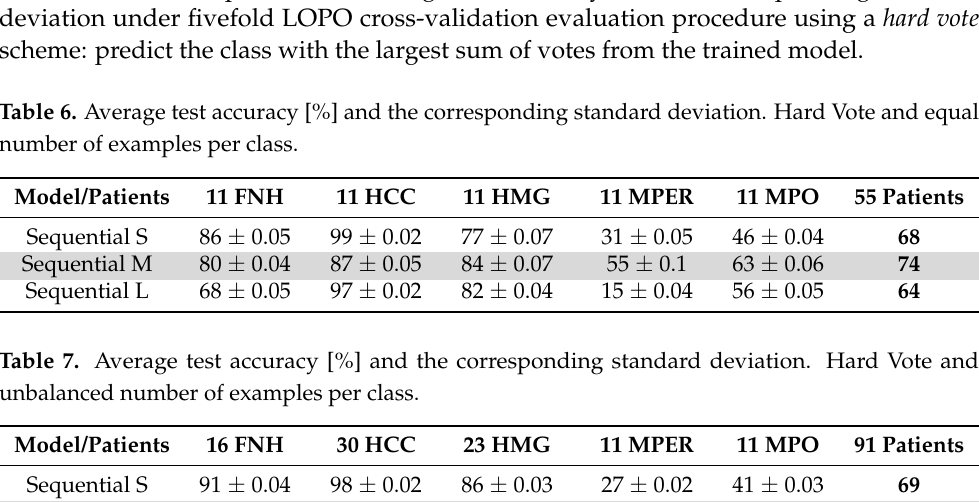
Figure 7. Experiment # 4 from a total of five-accuracies. The Boxplot representation extends from the lower to upper quartile values of the data, with a line at the median.